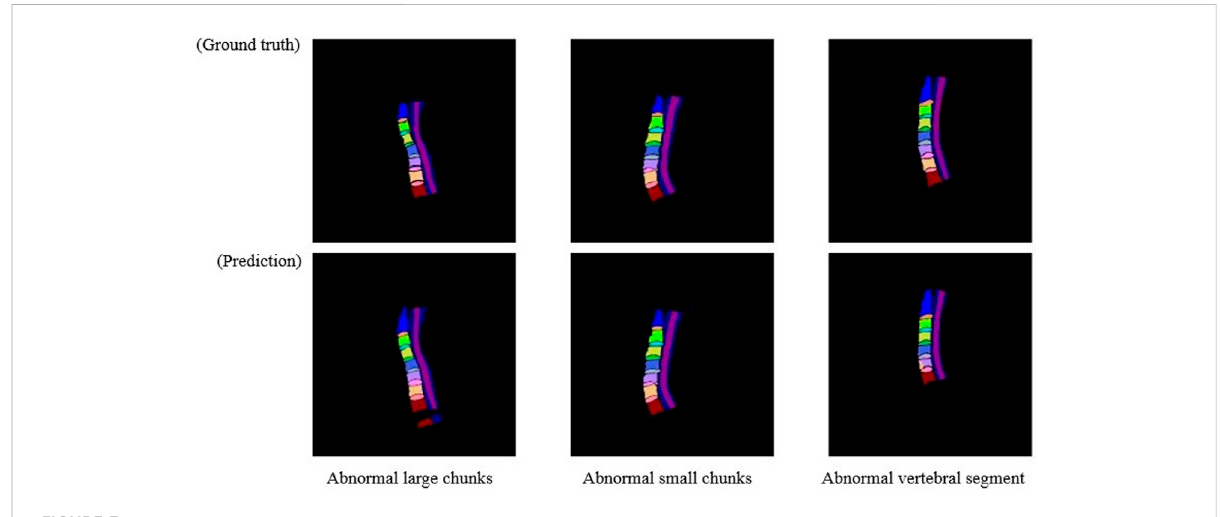
FIGURE 3 Three main anomaly segmentation cases from the validation set.